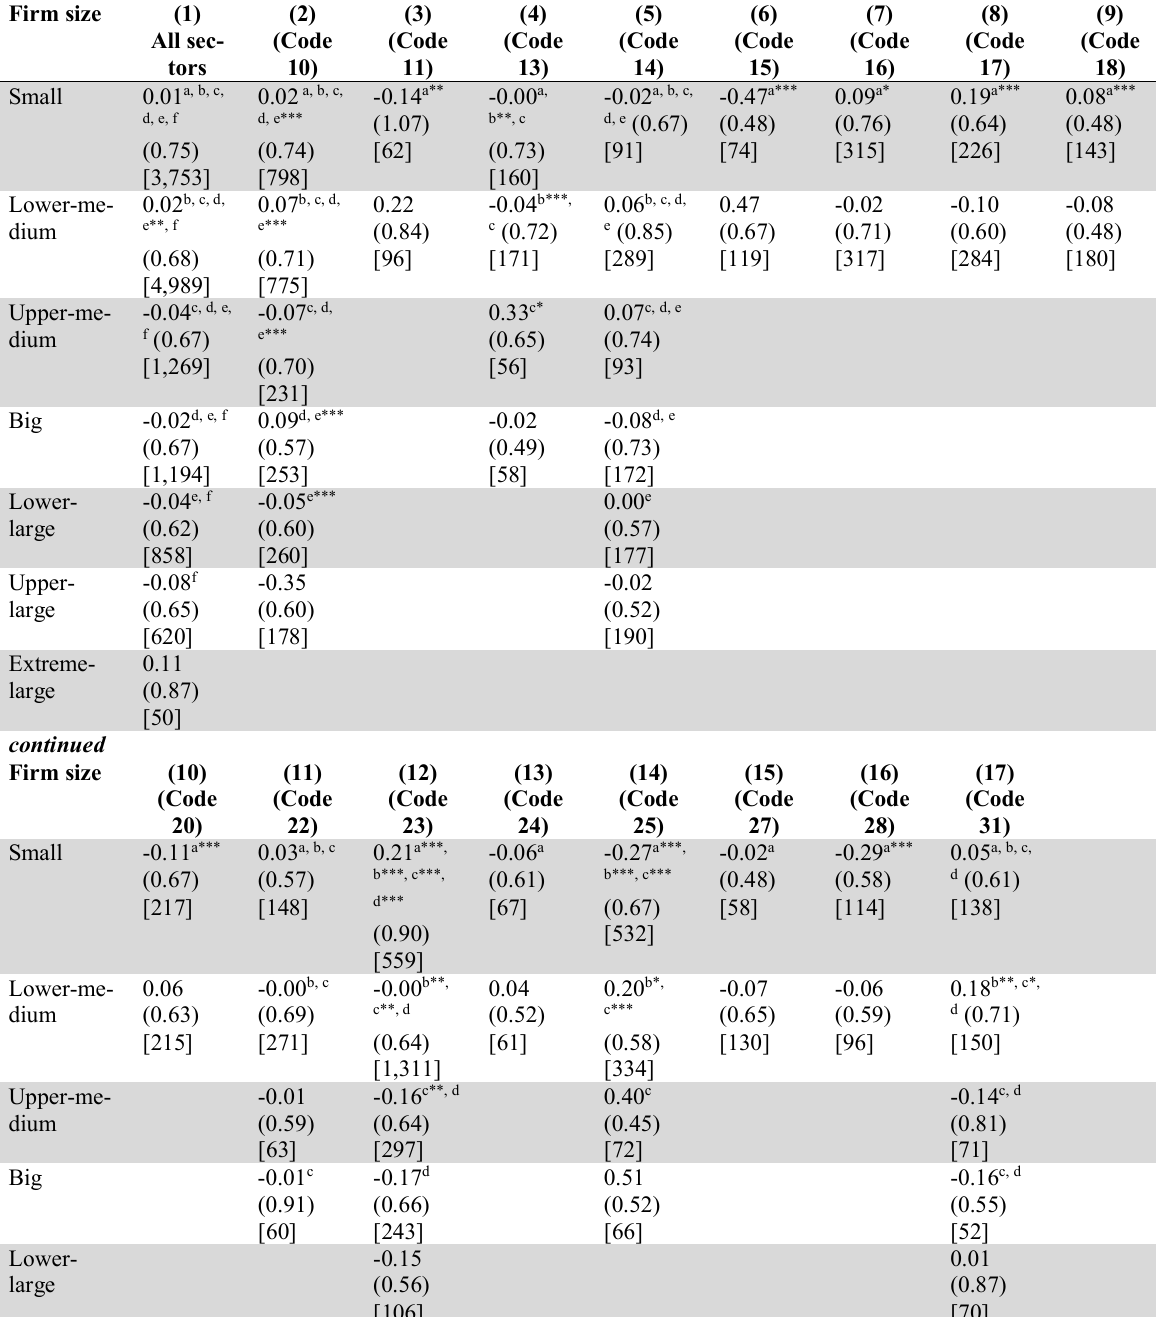
Labor heterogeneity in TFP dispersion: Vietnamese manufacturing domestic private sector